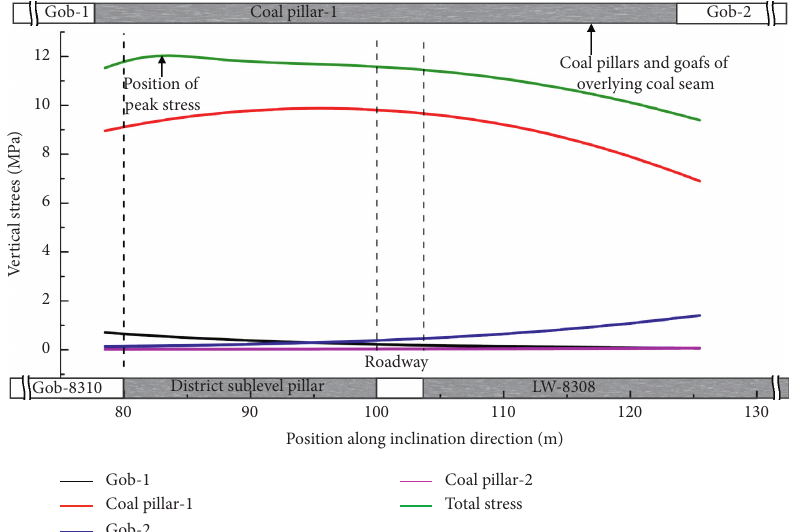
Figure 6: Stress distribution of overlaying coal pillars in the upper layer, goaf, and lateral supports.